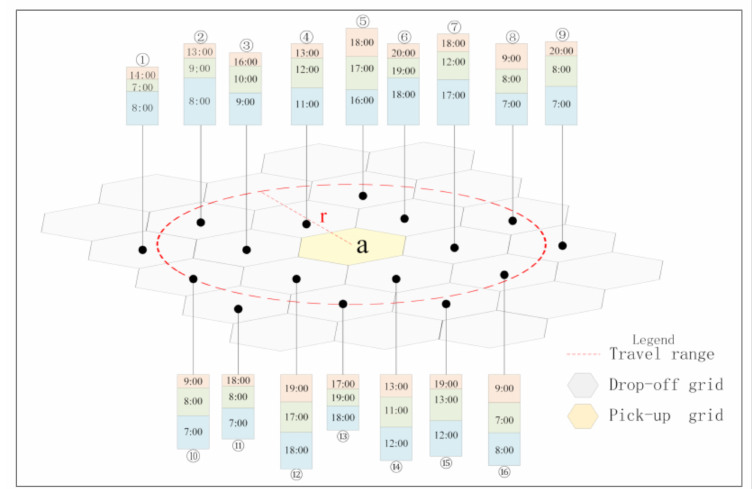
Figure 10. Period with the largest number of